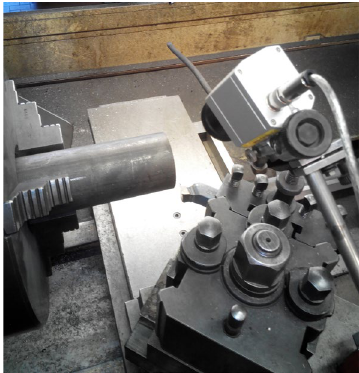
Figure 2. The experimental setup adopted during the dry finish turning tests of the Ti6Al4V cylin- drical parts.